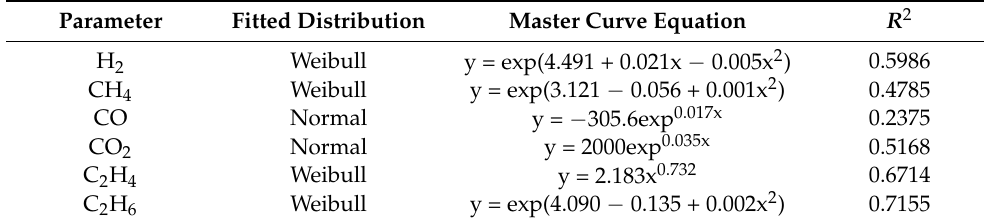
Table 5. The representative distribution for dissolved gas parameters data. Parameter Fitted